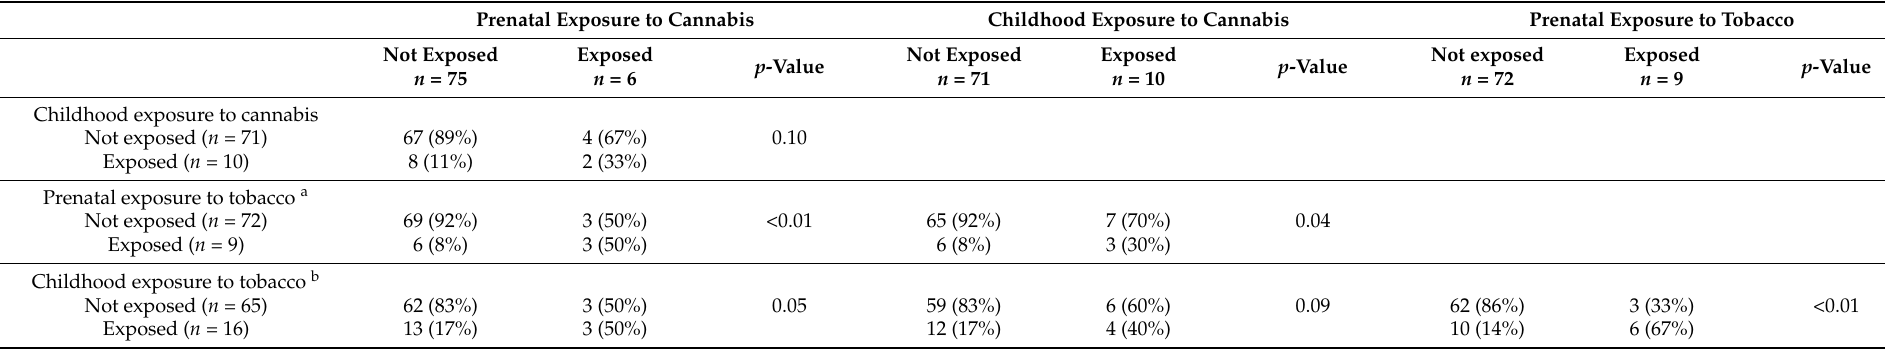
Table 3. Comparison of early-life exposure to cannabis and